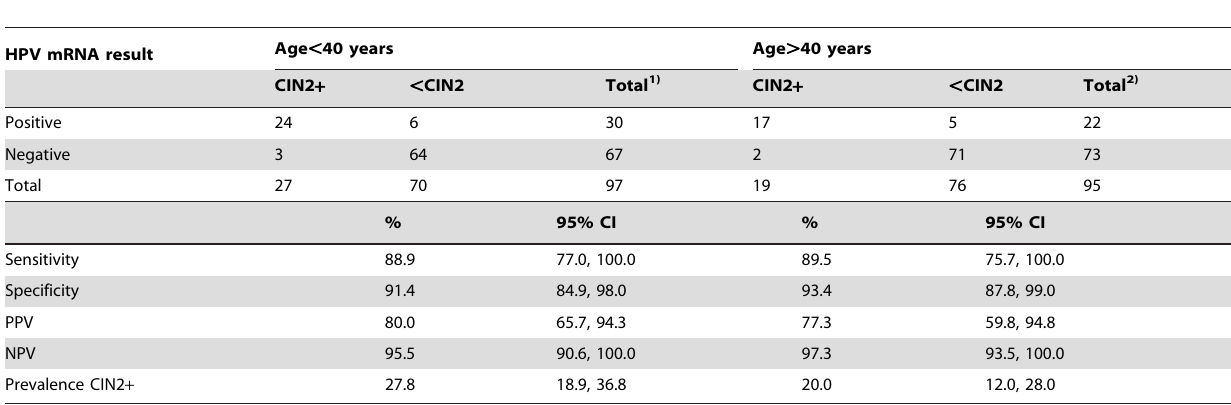
Table 8. Outcome for the 97 women under 40 years and the 95 women above 40 years in the HPV group if triaged with post- colposcopy HPV mRNA